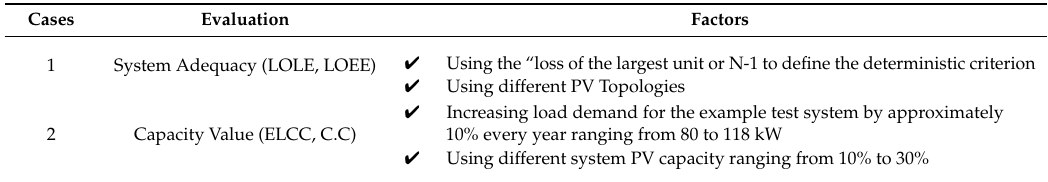
Table 6. Cases study results.